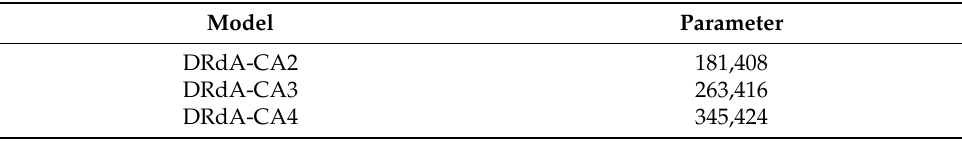
Figure 5. Classification accuracy at different depths. Table 3. The Parameters of Different